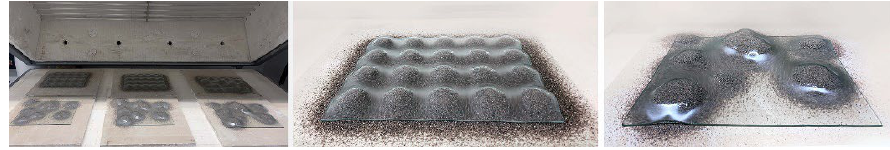
Fig. 7: a) Doubly curved glass in the kiln; b) glass slumping tests on a regular grid of extrusion points; c) an irregular grid of extrusion